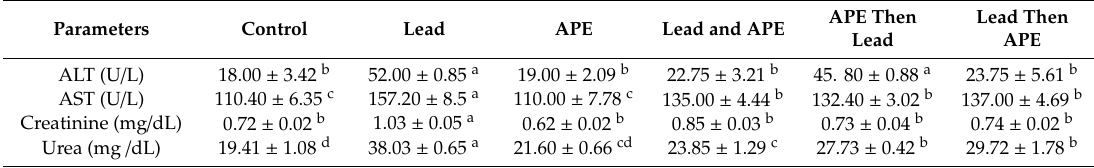
Table 3. The e ff ect of lead acetate and / or Azolla pinnata ethanolic extract (APE) on liver and kidney function biomarkers in rats.